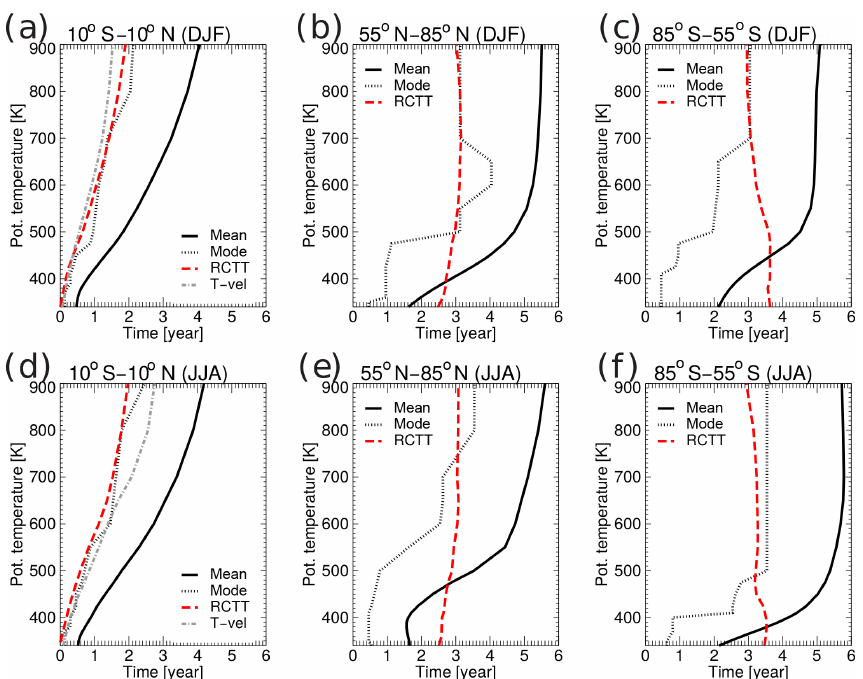
Figure 10. Profiles of mean age, modal age and RCTT for DJF (top) and JJA (bottom) at the equator, in the NH between 55 and 85 ◦ N, and in the SH between 55 and 85 ◦ S (from left to right). The grey dashed line in (a) and (d) shows the mean tropical upwelling time scale estimated from the zonal mean vertical